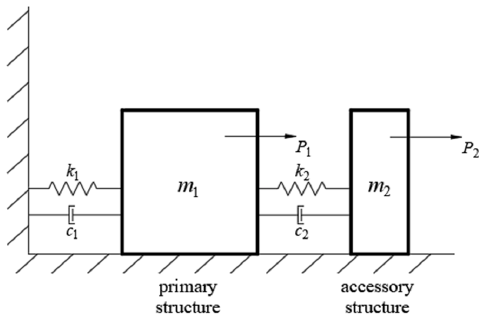
Figure 6. A two-degrees-of-freedom theoretical model for a hydraulic gate: the associated vibration (AV) system.